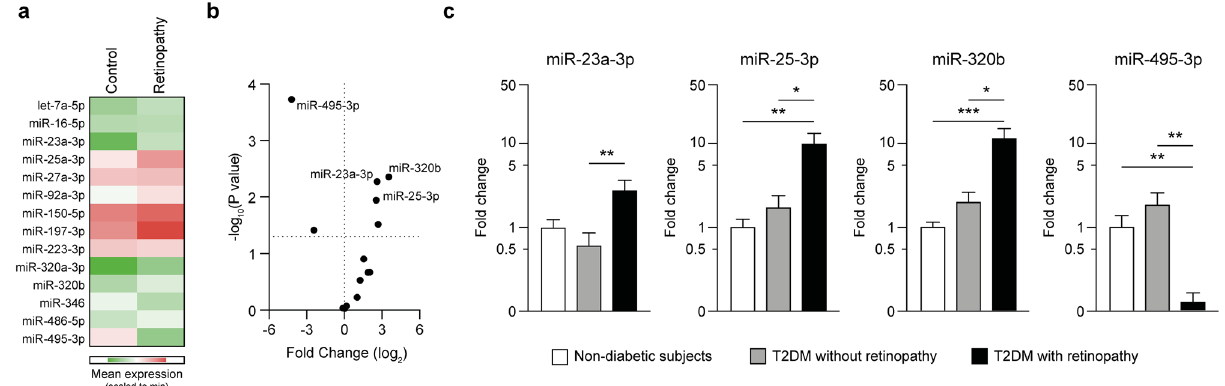
Figure 2. Validation of miRNA regulation by qPCR. ( a , b ) Expression of the selected miRNAs was performed by qPCR on diabetic patients without DR (Controls, n = 10) and with DR (Retinopathy, n = 20). Heatmap shows the mean expression of the miRNA in each group ( a ) and the Volcano plot reports the P-values by multiple t -tests ( b ). ( c ) Expression of the miRNAs showing a significant dysregulation in ( b ) measured in non-diabetic subjects (n = 10), diabetic patients without (n = 10) and with DR (n = 20). T2DM, type 2 diabetes. *p < 0.05; **p < 0.01; ***p < 0.001 as computed by univariate ANOVA with Bonferroni post-hoc